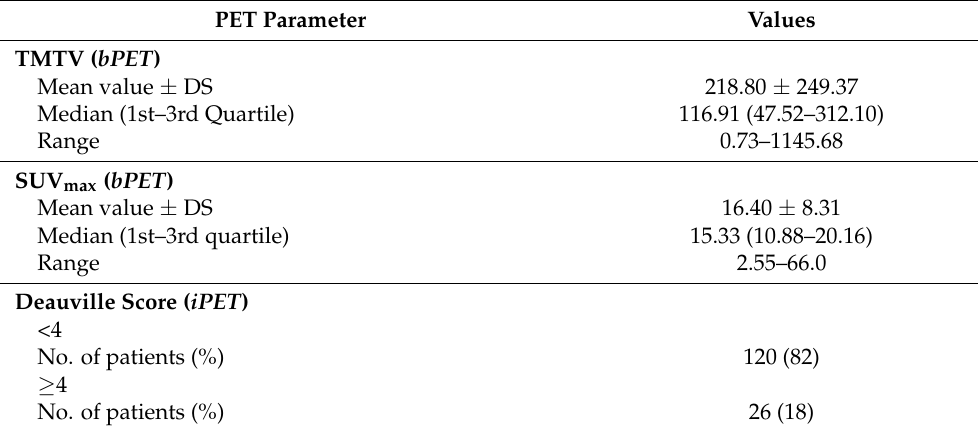
Table 2. Baseline and interim PET parameters considered for the whole cohort (n. 146).